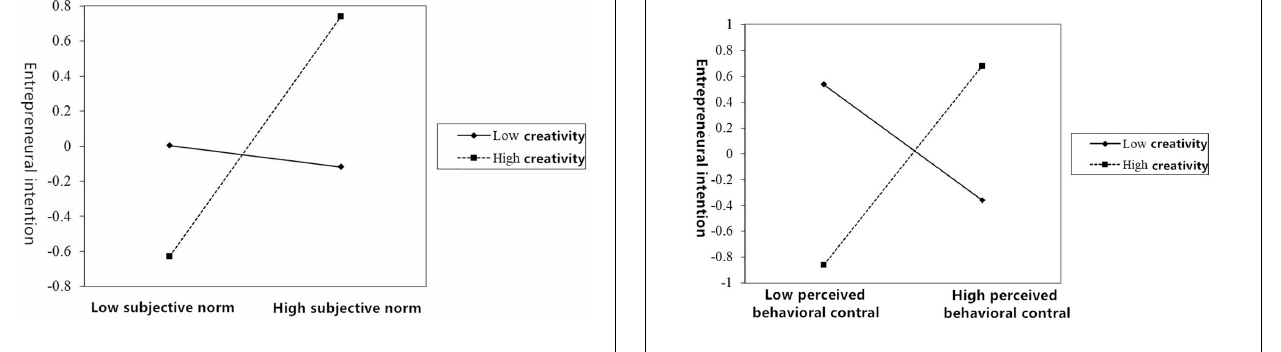
FIGURE 2 | A line chart of the moderating effect of creativity between subjective norms and entrepreneurial intention.